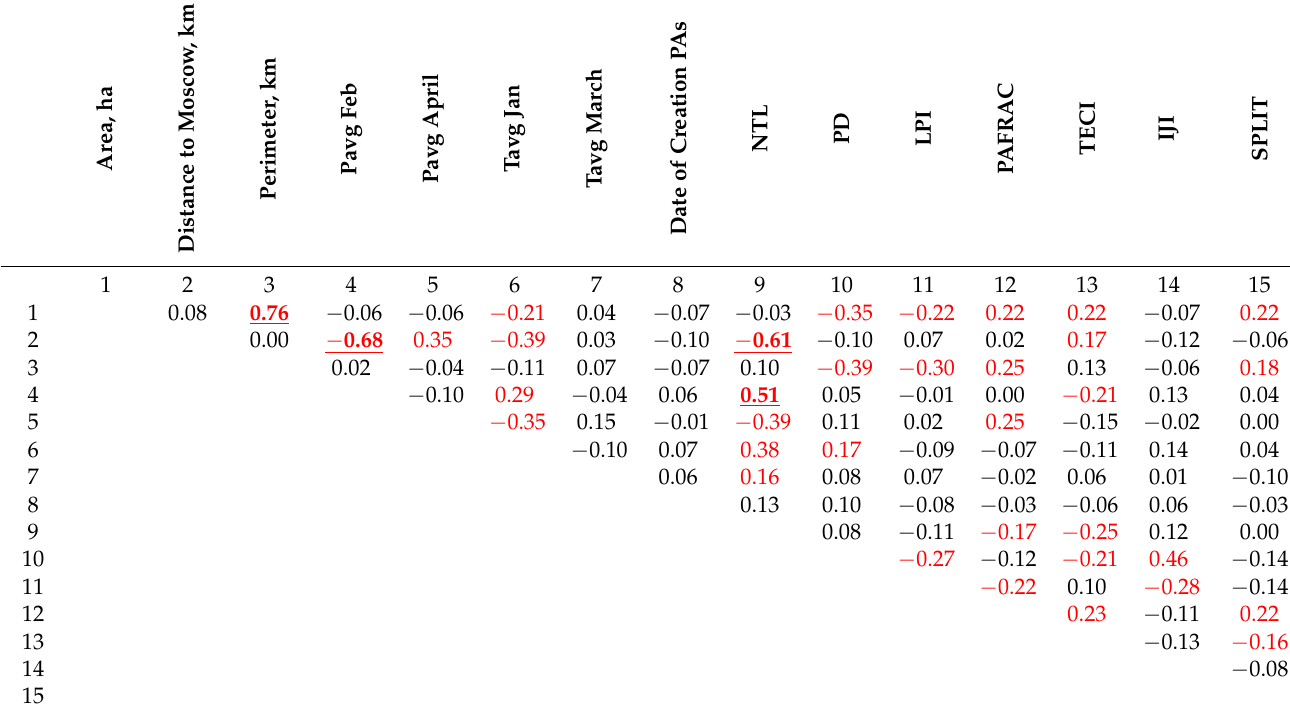
Table 5. Pairwise correlations between various environmental